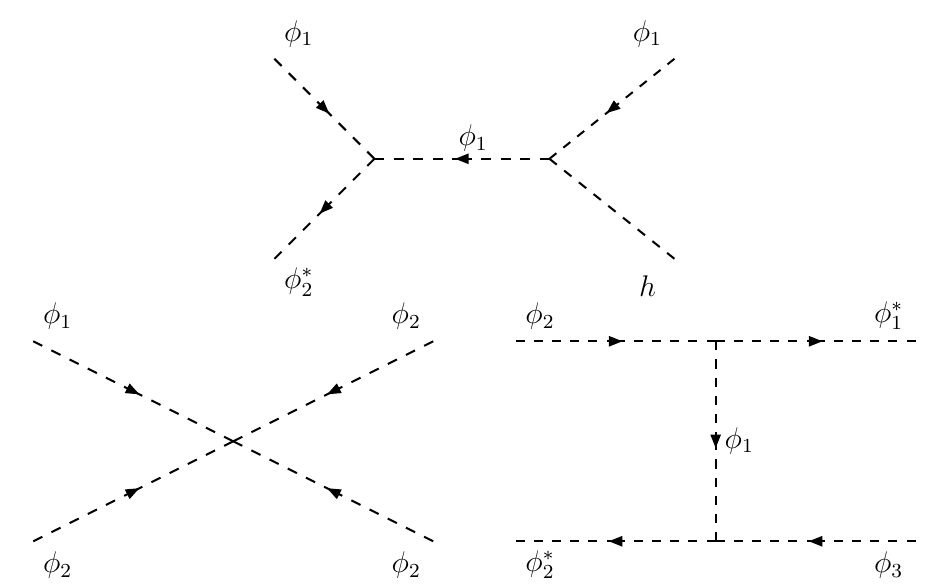
Figure 2 . Some examples of semiannihilation (top) and conversion (bottom) processes allowed in the Z 7